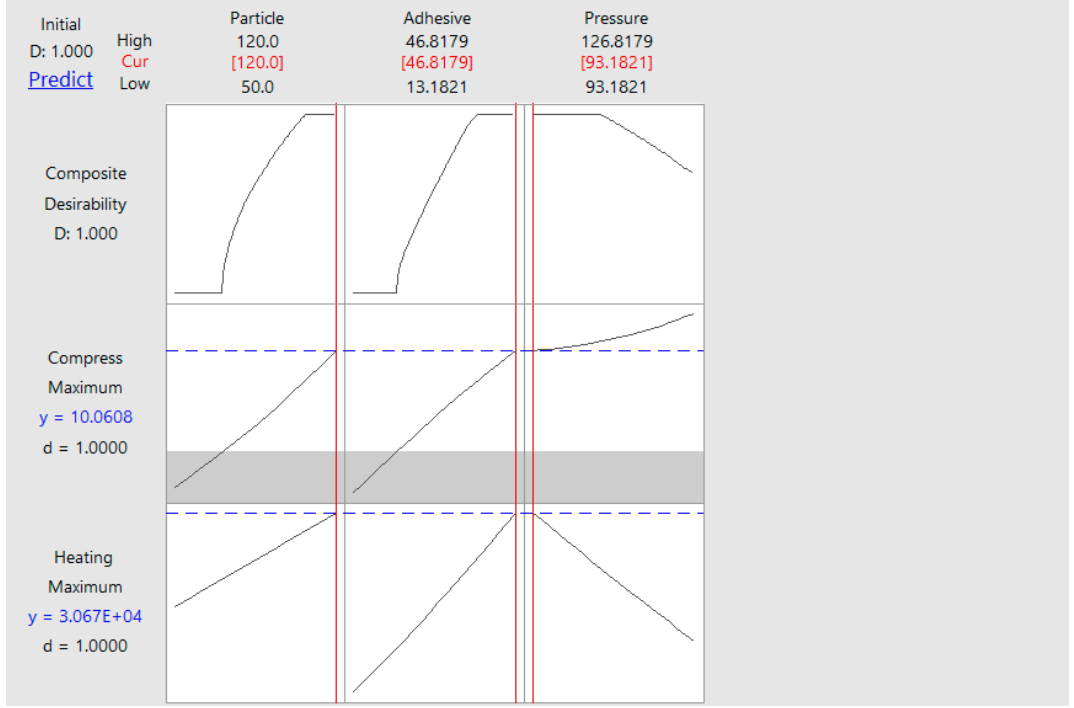
Figure 11. Maximum points of heating value and compressive strength with the factor